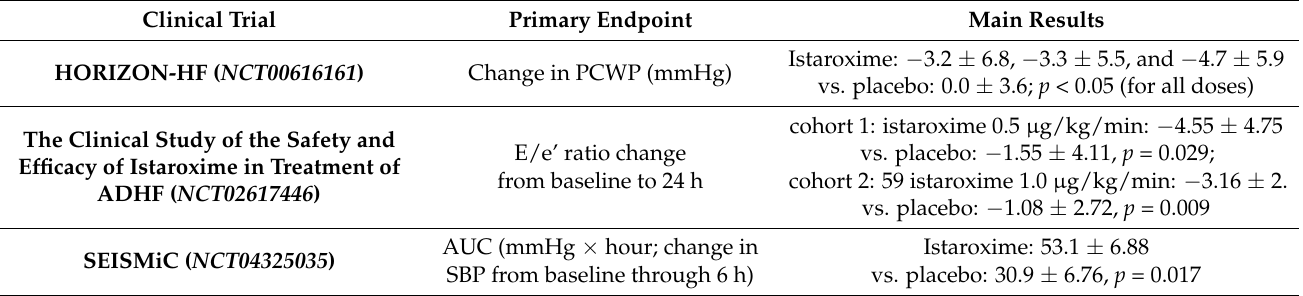
Table 2. Results of the main clinical trials on